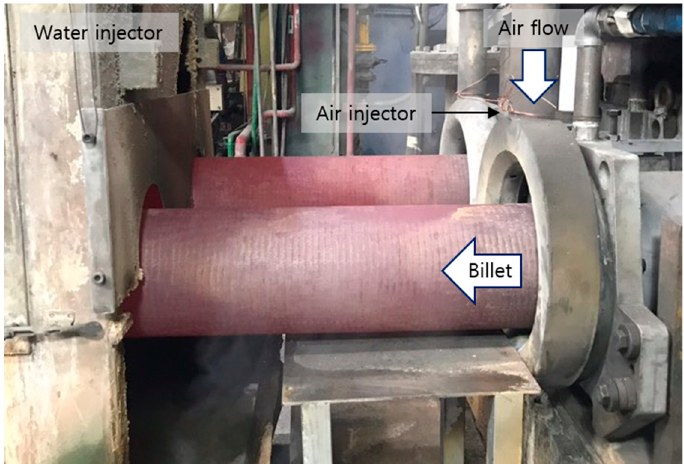
Figure 1. Brass billet continuous casting process.